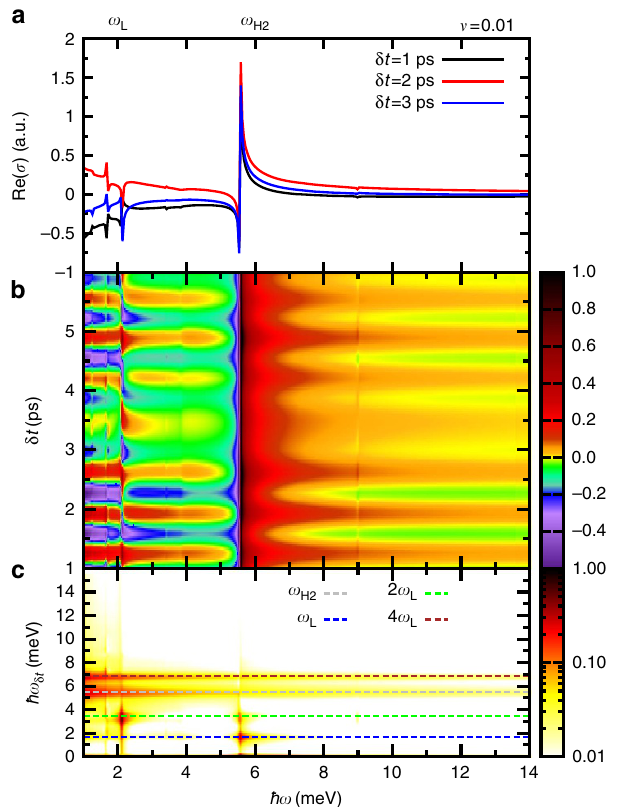
Figure 6 | Pump–probe spectrum. ( a ) Real part of the pump–probe response Re[ s ( d t , o )] as a function of frequency o for a two-band superconductor excited by the same pump pulse as in Fig. 2. Both the energy of the non-equilibrium Leggett mode o L and the Higgs mode o H2 are visible in the pump–probe signal as sharp peaks. ( b ) Temporal evolution of Re[ s ( d t , o )]. The intensity of the pump–probe signal is represented by the colour scale with dark red and dark violet, indicating high and low intensities, respectively. ( c ) Fourier spectrum of the pump–probe signal. The pump–probe spectrum oscillates as a function of pump–probe delay time d t with the frequencies of the non-equilibrium Higgs mode o H2 (dashed gray), the frequency of the non-equilibirum Leggett mode o L (dashed blue) and the frequencies of higher harmonics of the Leggett mode 2 o L (dashed green) and 4 o L (dashed